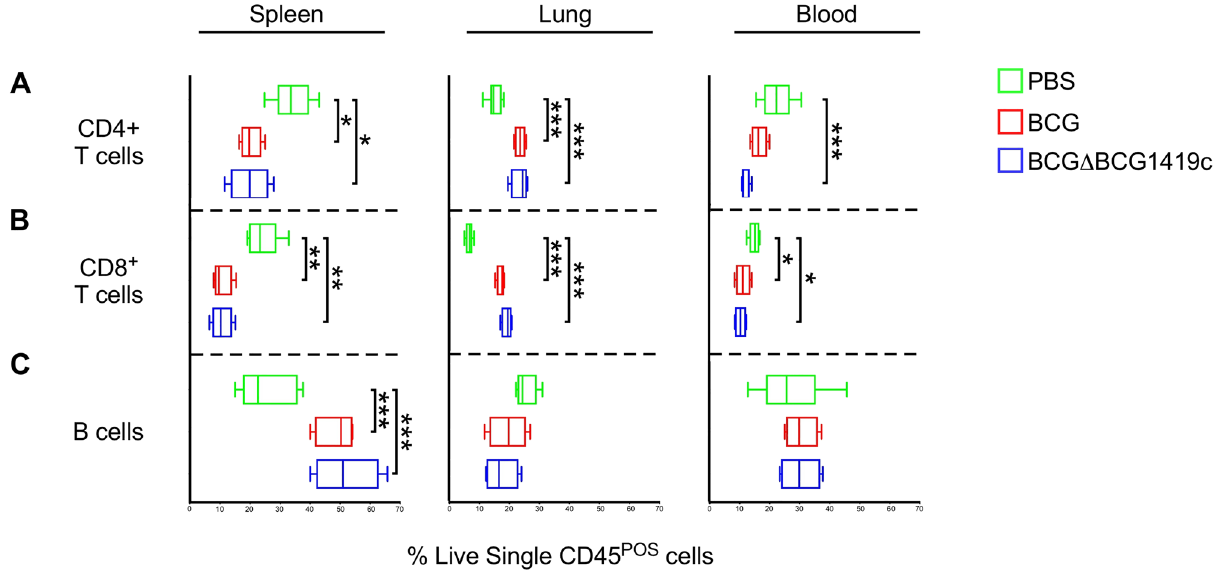
Figure 4. Adaptive immune subset frequencies in BCG- and BCGΔBCG1419c-immunized mice. Adaptive immune subset (i.e. T and B cell) frequencies in BCG- and BCGΔBCG1419c-immunized mice, as well as PBS controls, were measured in the spleen, lung and blood on post-immunization day 18. Shown are the frequencies of ( A ) CD4 + T cells, ( B ) CD8 + T cells and ( C ) B cells in the spleen (left column), lung (middle column) and blood (right column), as gated off of live single CD45 + cells. Boxes represent data from 3 mice per group; asterisks represent a statistically significant difference between indicated rows (*p ≤ 0.05; **p ≤ 0.005; ***p ≤